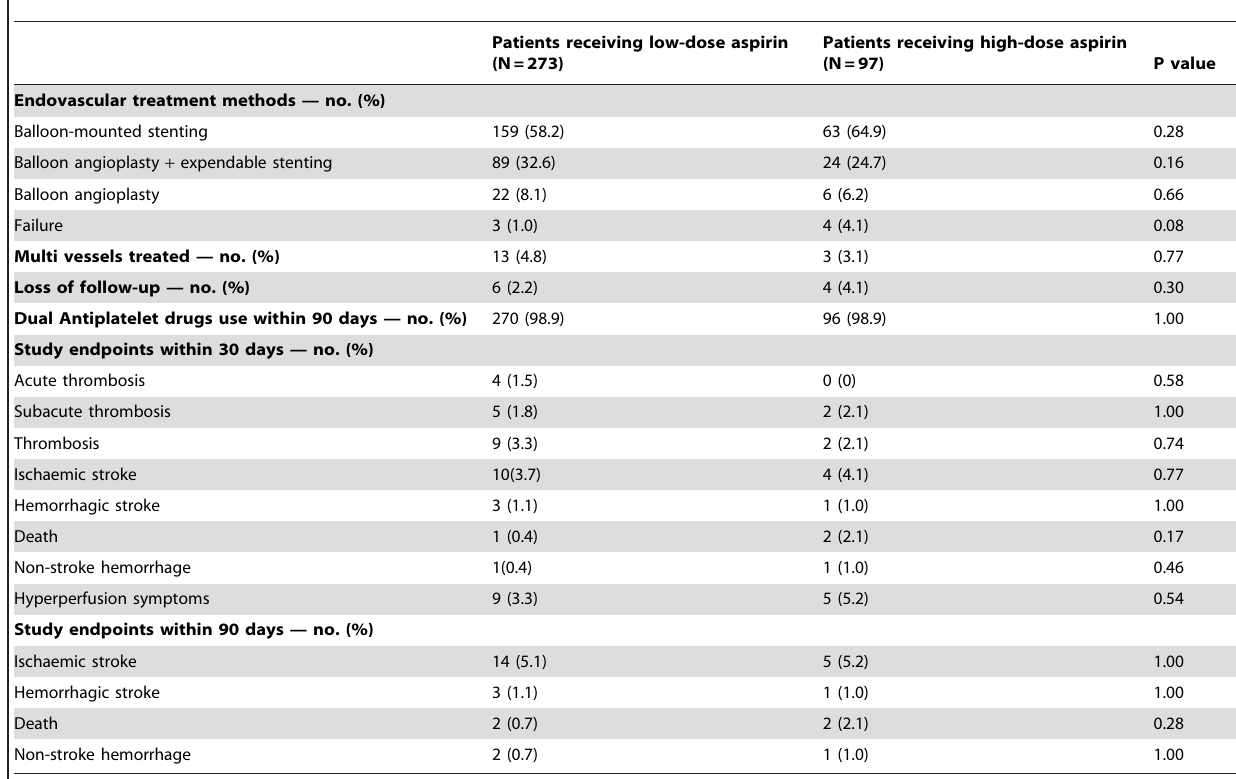
Table 2. Comparison of endovascular treatment data and study endpoints within 30 days and 90 days after intervention of patients receiving low-dose aspirin and patients receiving high-dose